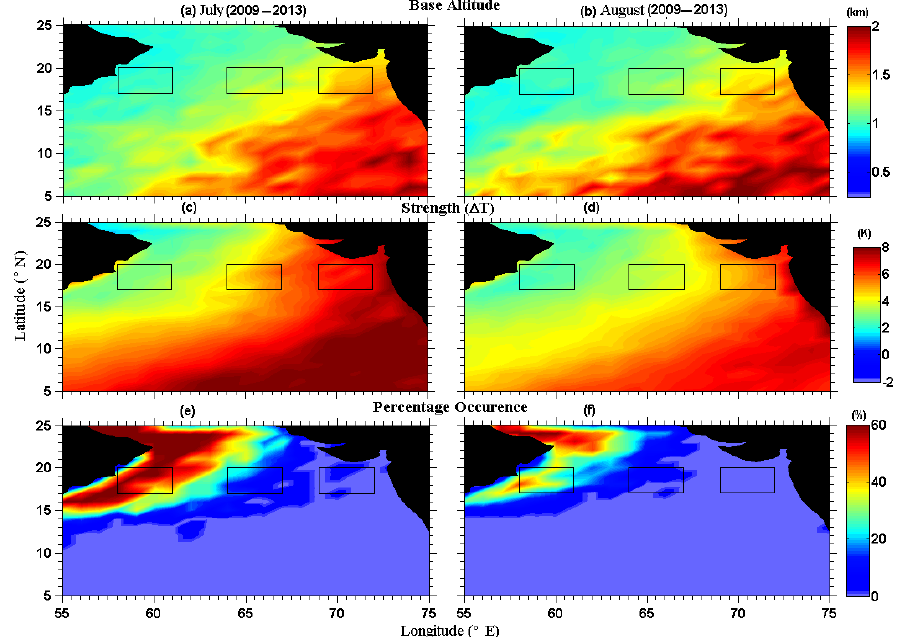
Figure 3. Base altitude occurrence of MI during (a) July, (b) August; (cid:49)T (strength) of MI (c) July, (d) August; and percentage occurrence of MI days (e) July, (f) August, averaged during 2009–2013 observed by IASI (we select the WAS, CAS and EAS from this